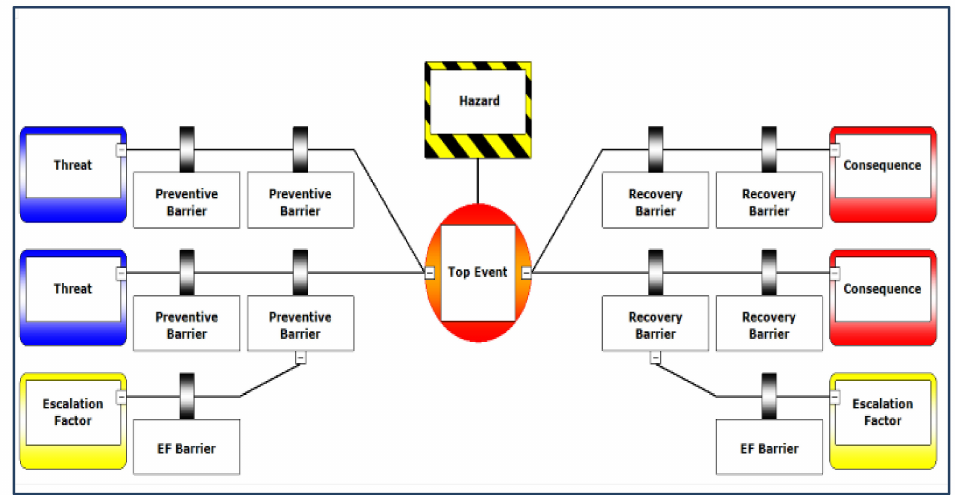
Figure 2. Bowtie Risk Assessment Model, CGE Risk Management Solutions